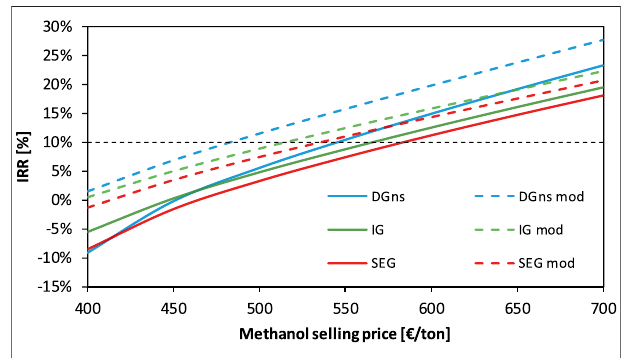
FIGURE12| IRRoftheDGns-,IG-,andSEG-basedplantsasafunction of the methanol selling price for an electrolyzer investment cost of 400 € /kW. Curves are derived from the two electricity price curves shown in Figure 9